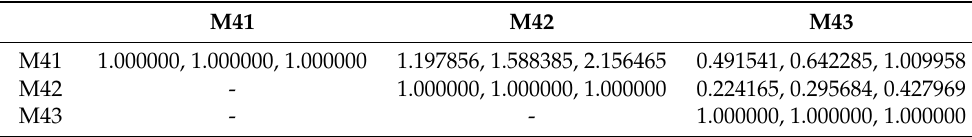
Table 8. Pair-wise fuzzy multi-criteria decision comparative matrix for protected system.